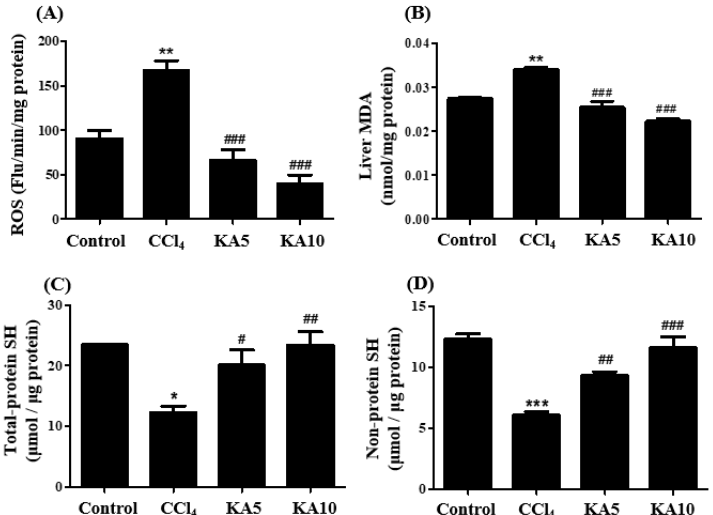
Figure 7. Effect of kaempferol on ROS ( A ), MDA ( B ), total SH ( C ), and non-protein SH ( D ) levels in rat livers intoxicated with CCl 4 . Values are mean ± SE of n = 6 rats/group. * p < 0.05, ** p < 0.01, and *** p < 0.001 vs. the control group, and # p < 0.05, ## p < 0.01, and ### p < 0.001 vs. the CCl 4 group.